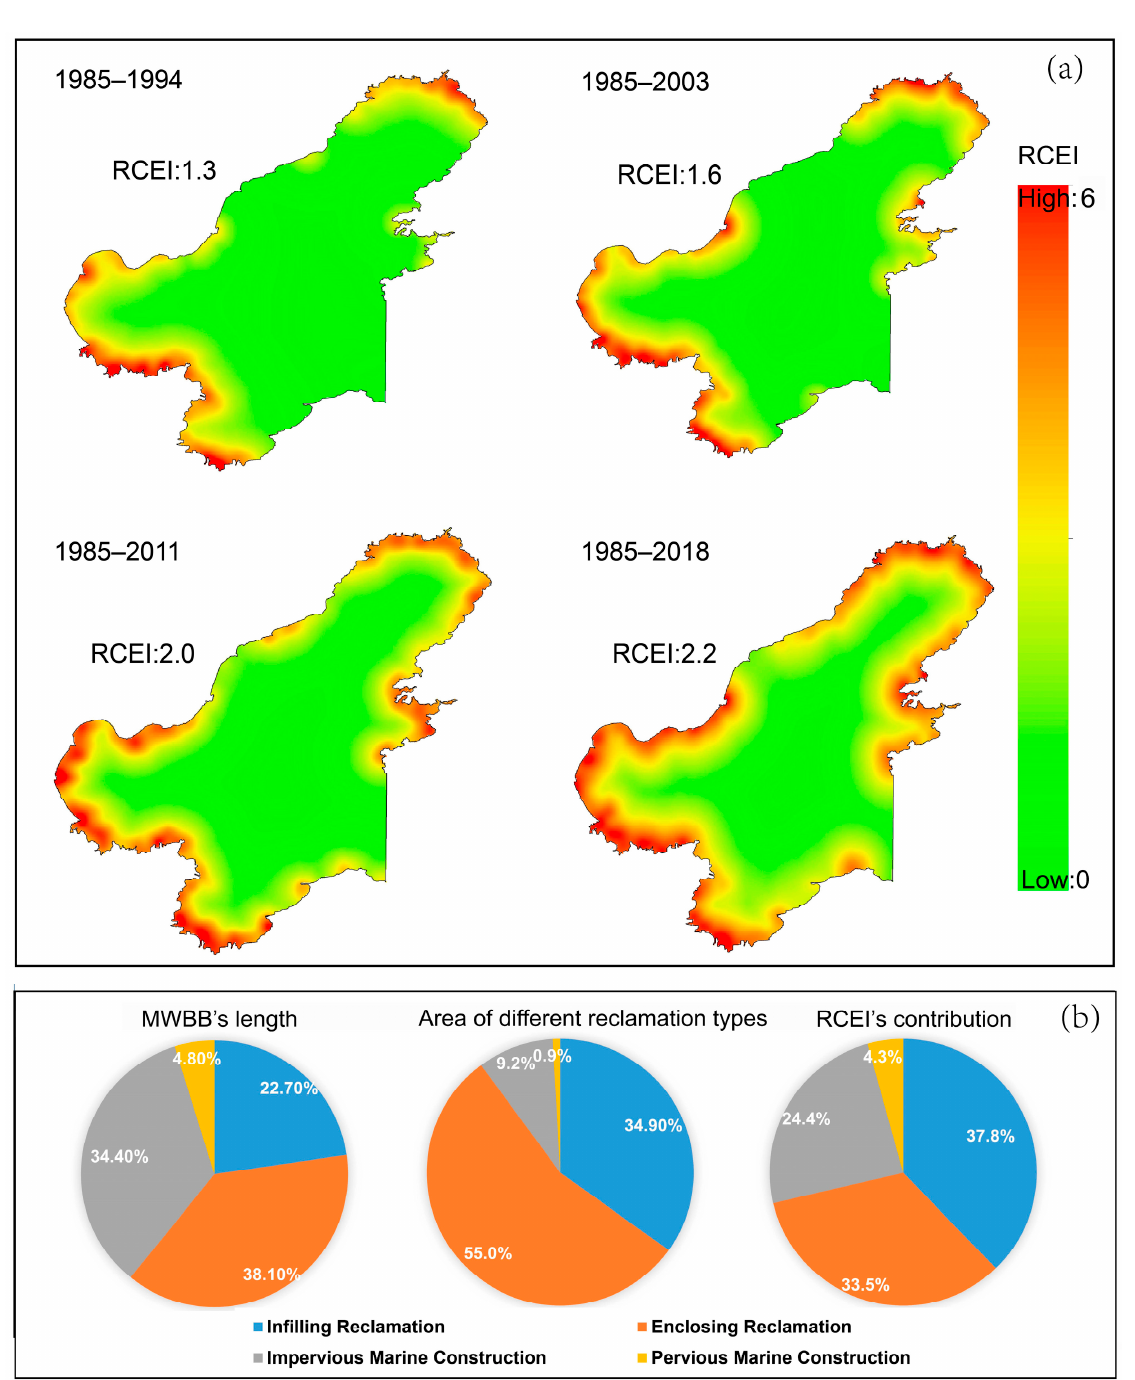
Figure 9. Spatio-temporal changes of the RCEI in the Bohai Sea ( a ) and the ratio of MWBB’s length, RCEI’ s contribution, and the area of different reclamation types ( b ).